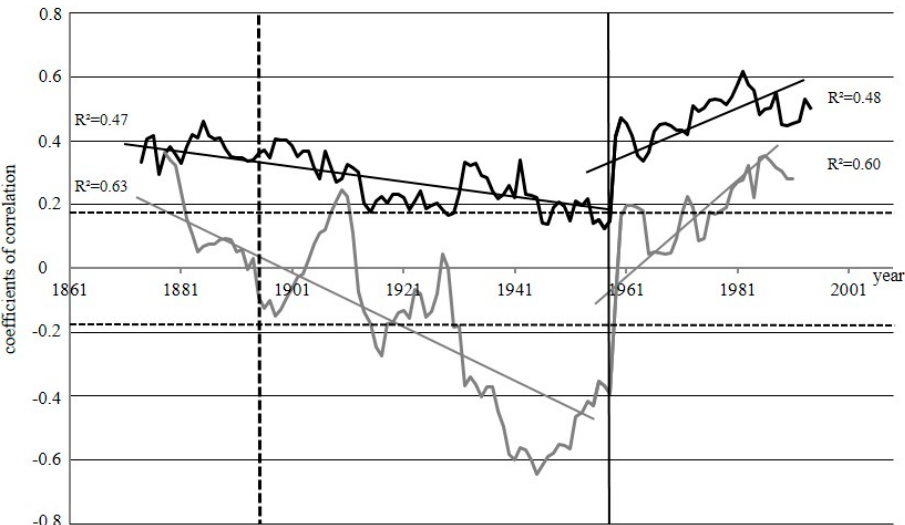
Figure 5. Running correlations between δ 13 C and δ 18 O by the 30—years window for DS (black line) and WS (grey line); the vertical line represents the “break point”~1960; the vertical dotted line indicates the fire event in 1896 at DS. The horizontal dotted lines indicate the threshold for significance at p < 0.05 (r = 0.19, n = 113). R 2 —coefficient of regression of the approximation lines for different periods.